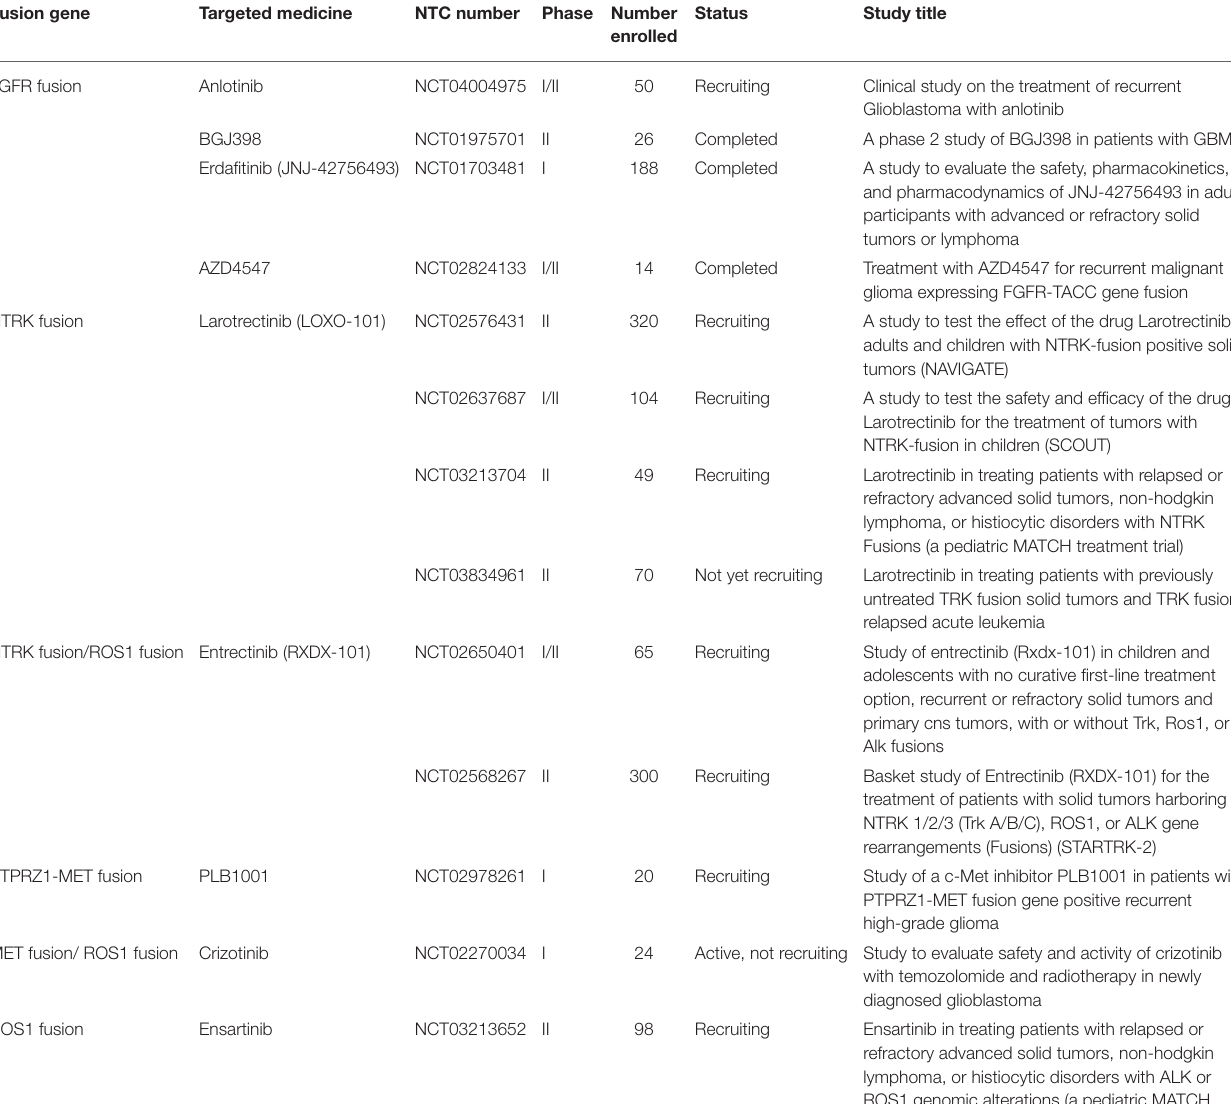
TABLE 3 | Ongoing clinical trials involving fusion genes in GBM. Fusion